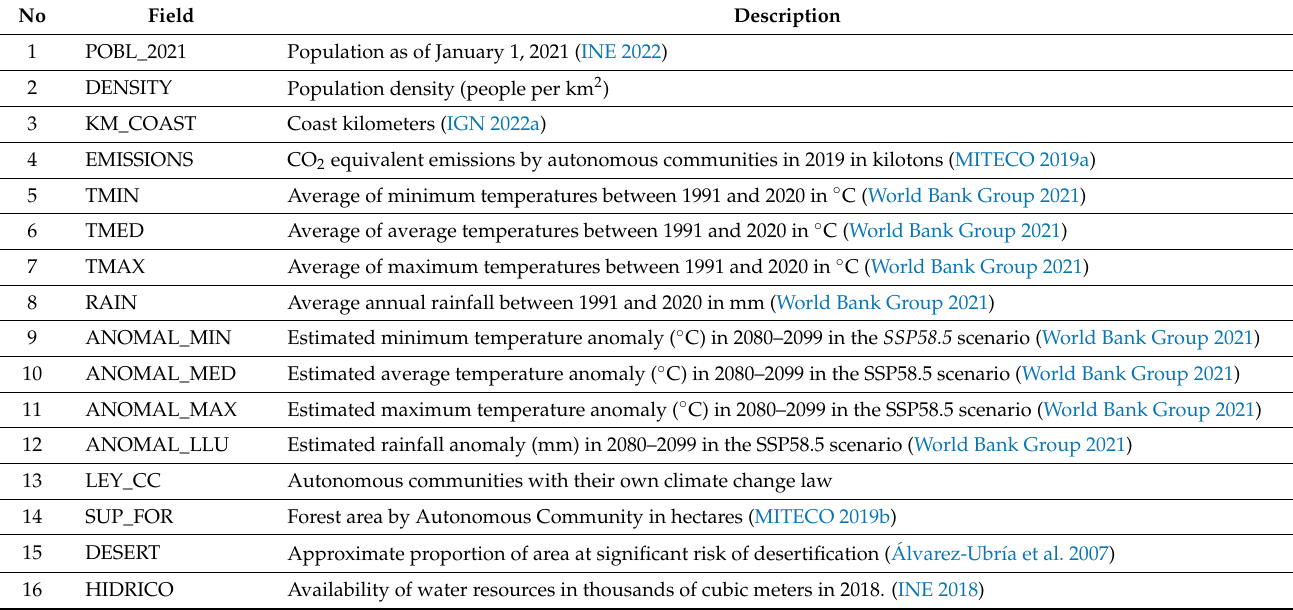
Table 5. Fields of the proposed vector